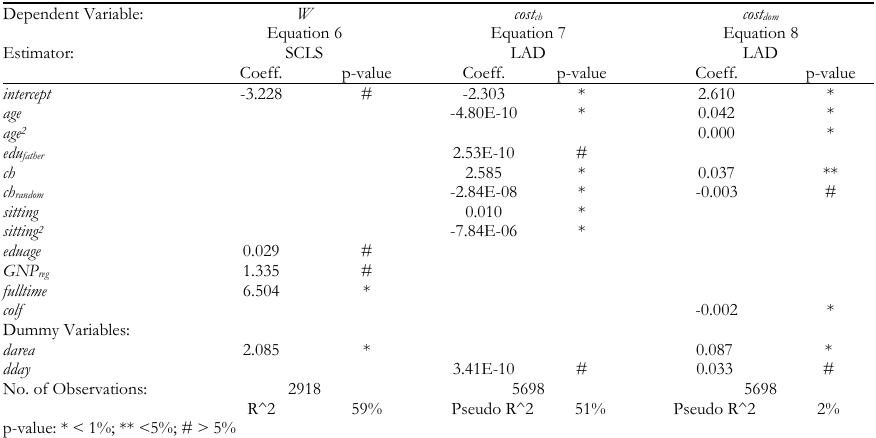
Reduced form semiparametric estimation of log-wage equation and cost of unpaid activities equations Dependent Variable: